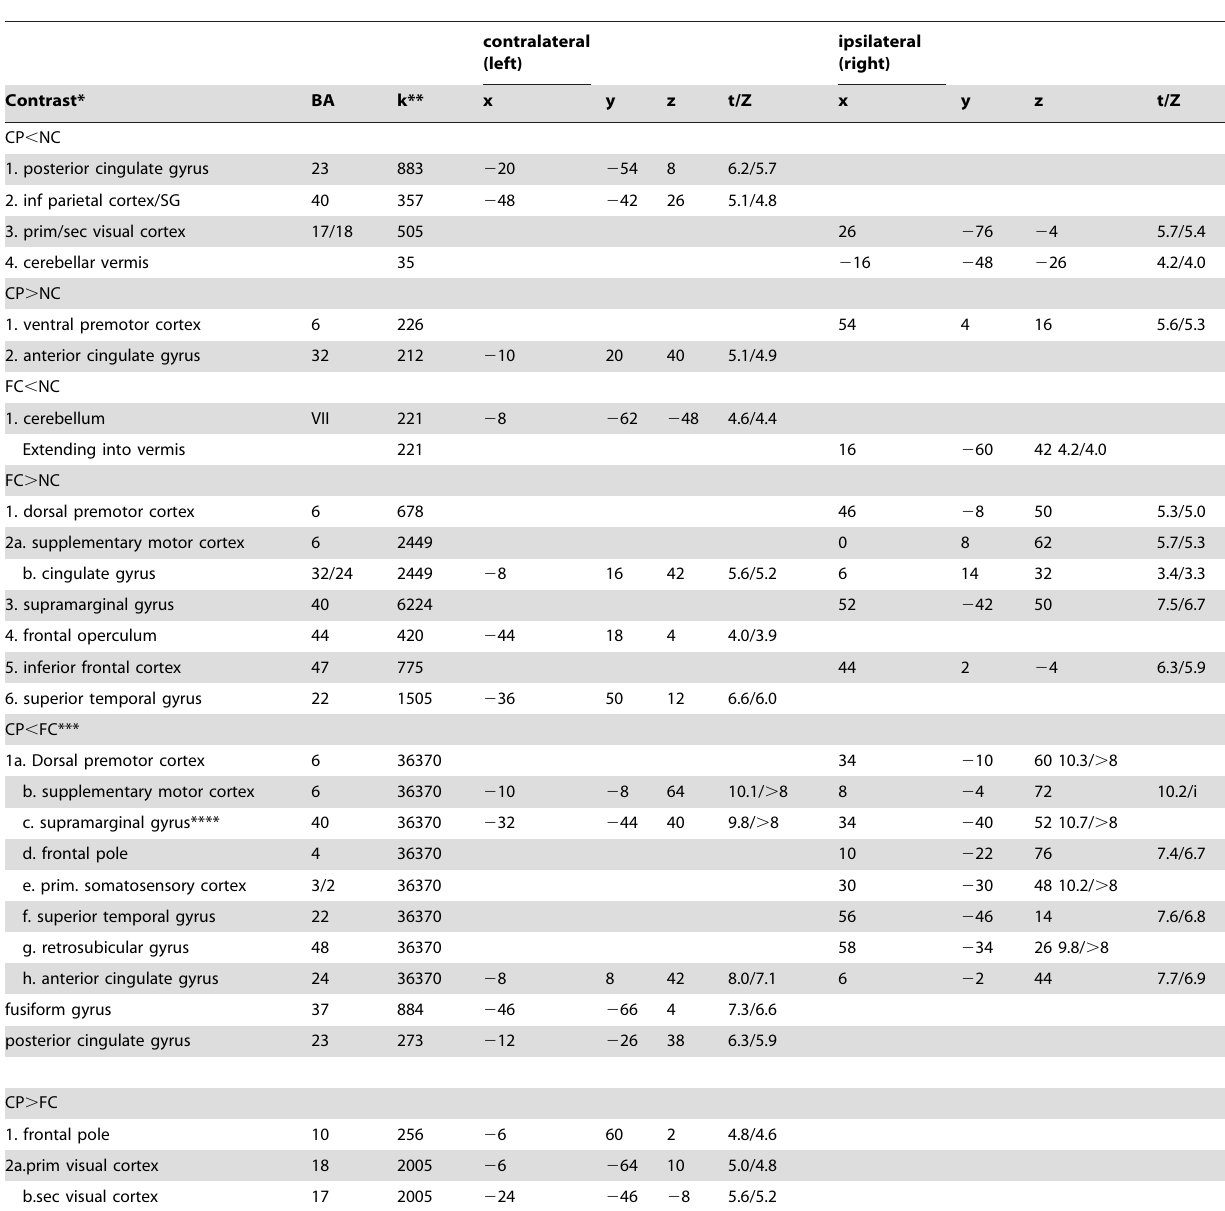
Table 6. Cerebral activation related to movement execution of the unaffected hand (left-sided patients and feigners were flipped).